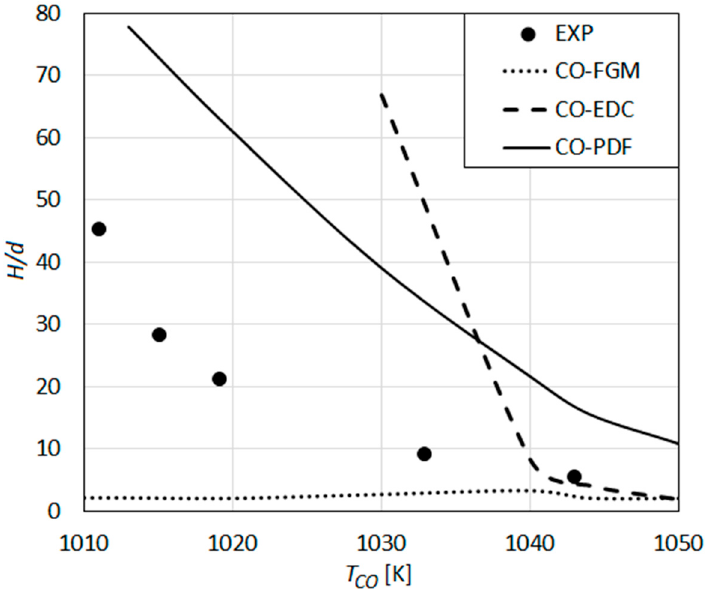
Figure 11. Lift-off height as a function of co-flow temperature: Predictions using the detailed reaction mechanism of Conaire et al. [60] compared with the measurements of Wu et al. [23].